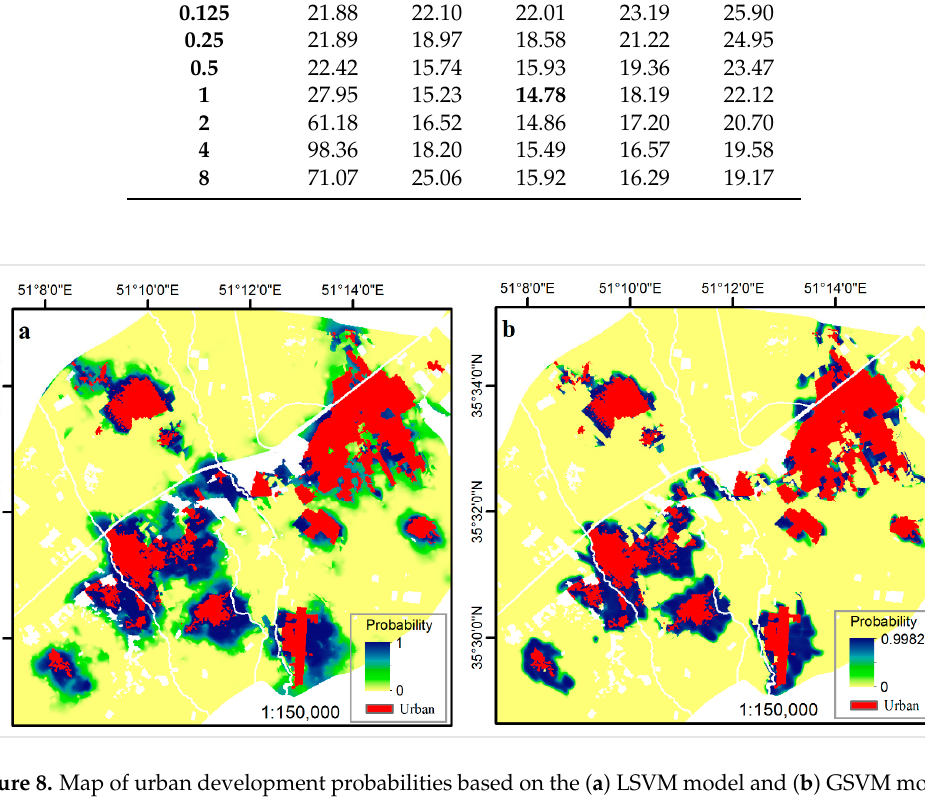
Table 3. Relationship between W Local , the AUC and the kappa coefficient.